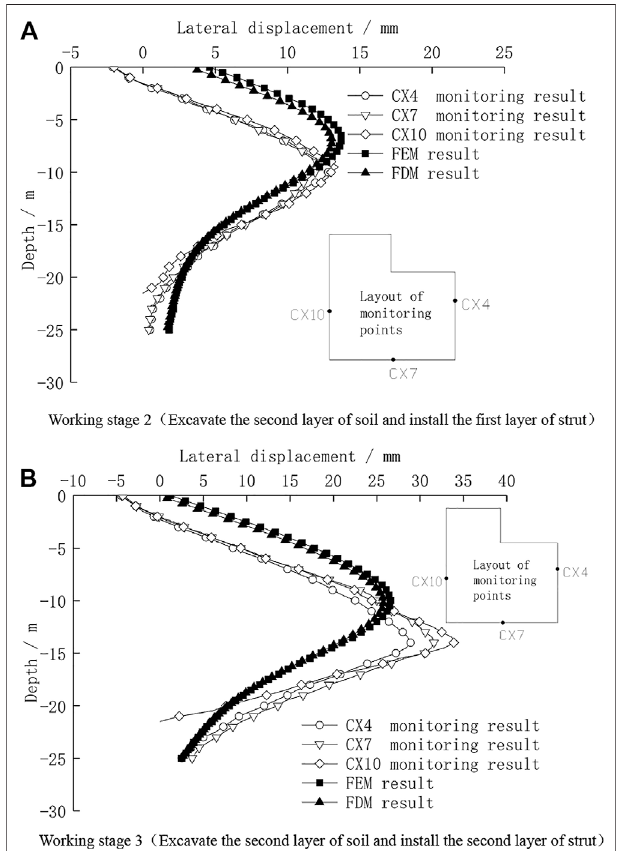
FIGURE6| Lateraldisplacementofretainingpilesduringconstructionof the basement. (A) Working stage 4 (Constructing the bottom fl oor and removing the second layer of the strut). (B) Working stage 5 (Constructing the B1 fl oor and removing the fi rst layer of the